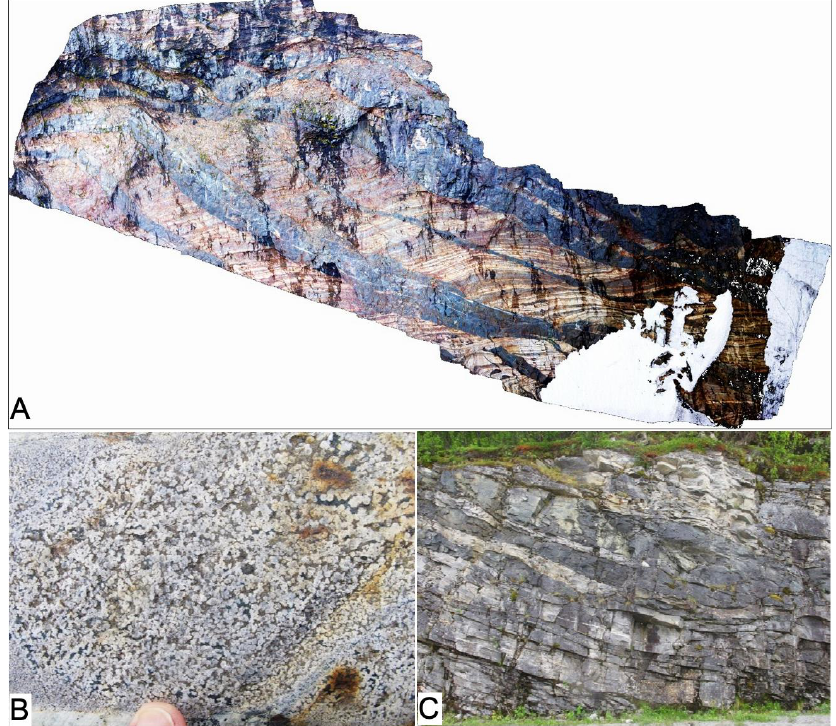
Figure 4. ( A ) Cliff wall partly draped by a glacier (to the right), at Rohkunborri National Park, showing Scandinavian Dyke Complex dolerites truncating Ediacaran syn-rift sediments of the Seve Nappe Complex. The stratigraphy is right-way-up and shows meta-evaporites (lower right), calcareous sandstones and sandstones (upper left). The image is a mosaic of 25 high-resolution geo-referenced drone images. The stratigraphic thickness shown from lower right to upper left is ~140 m and the prominent dyke in the central lower part of the image is ~7 to 10 m thick ( B ) Details of a mafic dyke at Rohkunborri, cutting the meta-evaporites (contact at fingertip). The dyke is strongly metasomatized with the formation of pre-orogenic, static growth of Cl-rich scapolite (Me 70 white crystals). This metasomatism reduces the rock density and hence also changes the petrophysical property of the basaltic rocks prior to later orogeny. ( C ) A 5 m high road section in felsic orthogneiss, intruded by numerous mafic sheets at the base of the Corrovarre lens in northernmost Norway. The felsic gneiss is Archean (see below and [92,100]), whereas the age of the mafic intrusives have not yet been dated. For locations of all images, see Figure